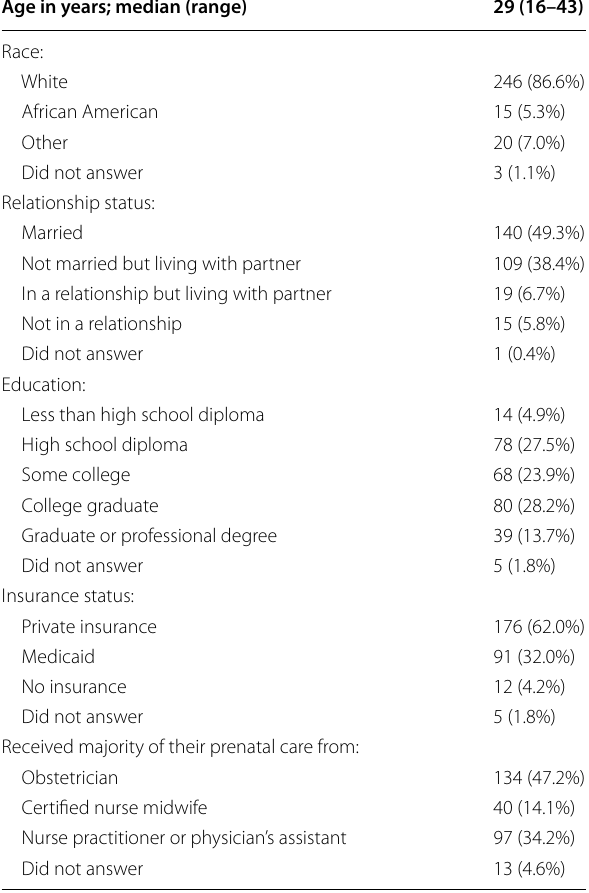
Table 3 Demographics of the 284 pregnant women